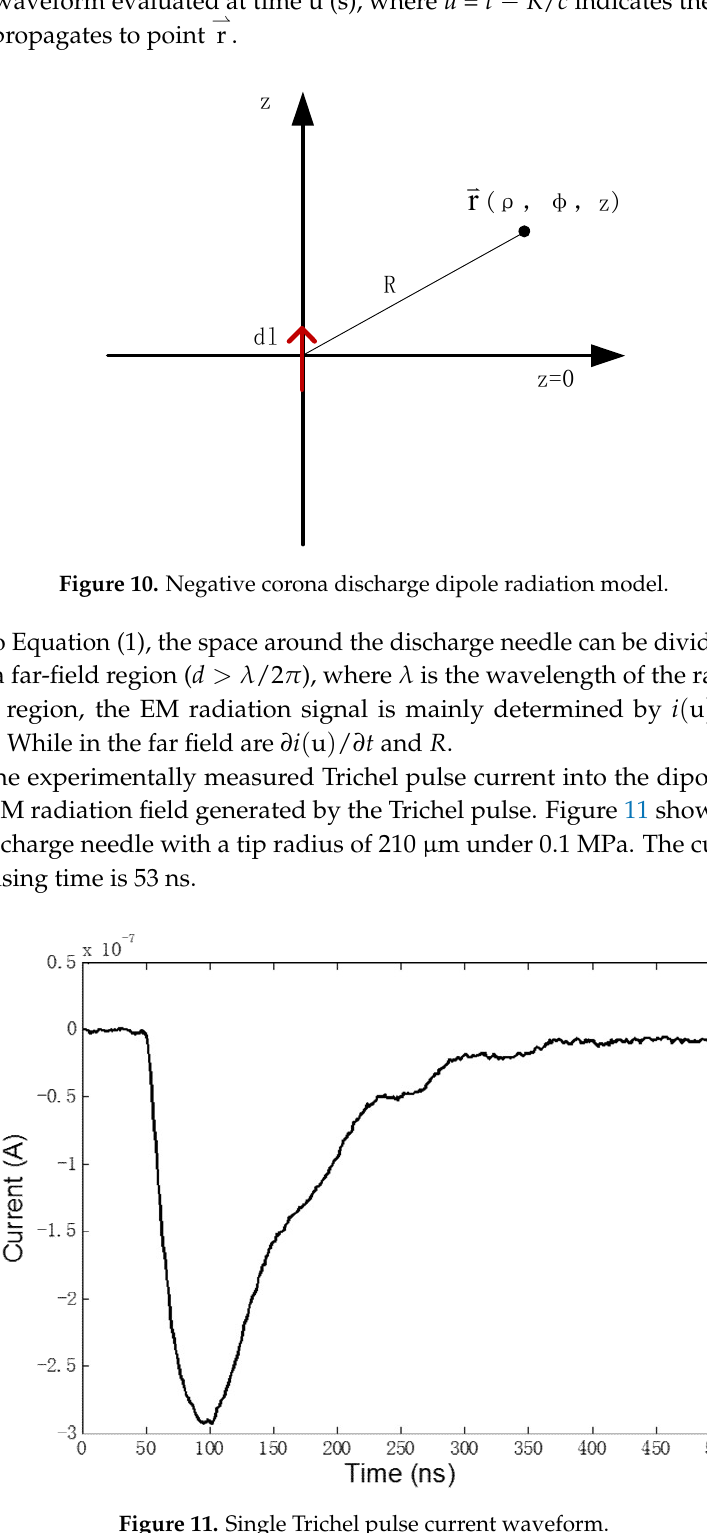
Figure 12. Discharge EM radiation field waveform. 4.2. Comparison of Calculation Results of Dipole Radiation Model with Experimental Test Results Document [21] has studied the effect of Trichel pulse current parameters on the discharge radiation spectrum. This paper mainly analyzes the relationship between the amplitude of discharge EM radiation field and Trichel pulse parameters. When the single Trichel pulse current waveform is the same, as the pulse repetition frequency increases, the average power of the radiation signal will increase, but the repetition frequency of the pulse will not affect the EM radiation signal that is generated by each pulse current, which is consistent with the experimental results (Figure 5). Figure 13 shows the relationship between the amplitude of EM radiation signal and the rising time of Trichel pulse. The tip radius of the needle used in the experiment is 94 μm. Trichel pulse current produced by negative corona discharge and its EM radiation characteristics were measured at ambient pressure of 0.1 MPa, 0.08 MPa, 0.06 MPa, and 0.04 MPa, respectively. We measured 20 sets of data at each ambient pressure, each of which was 10 μs long and contained about 20 Trichel pulses. The rising time of Trichel pulse measured at ambient pressure of 0.1 MPa, 0.08 MPa, 0.06 MPa,